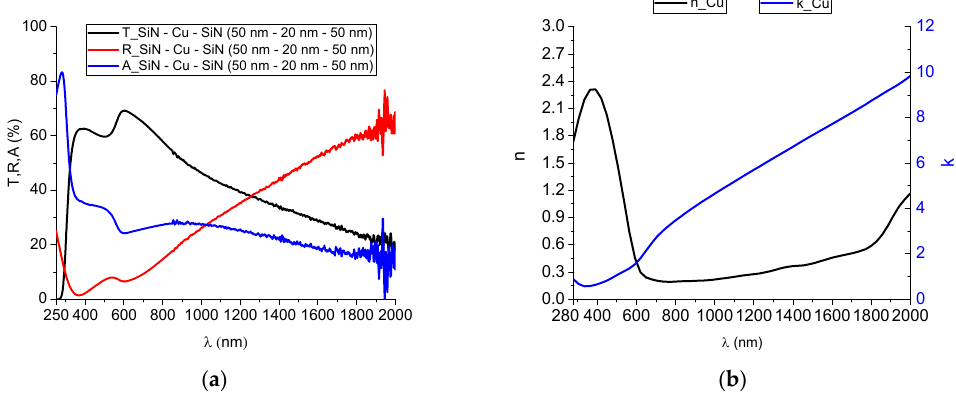
Figure 6. ( a ) Experimental spectrophotometric curves of the multilayer obtained on microscope glass substrate and ( b ) dispersion curves of the refractive index and absorption coefficient of the Cu layer between two SiN x layers.